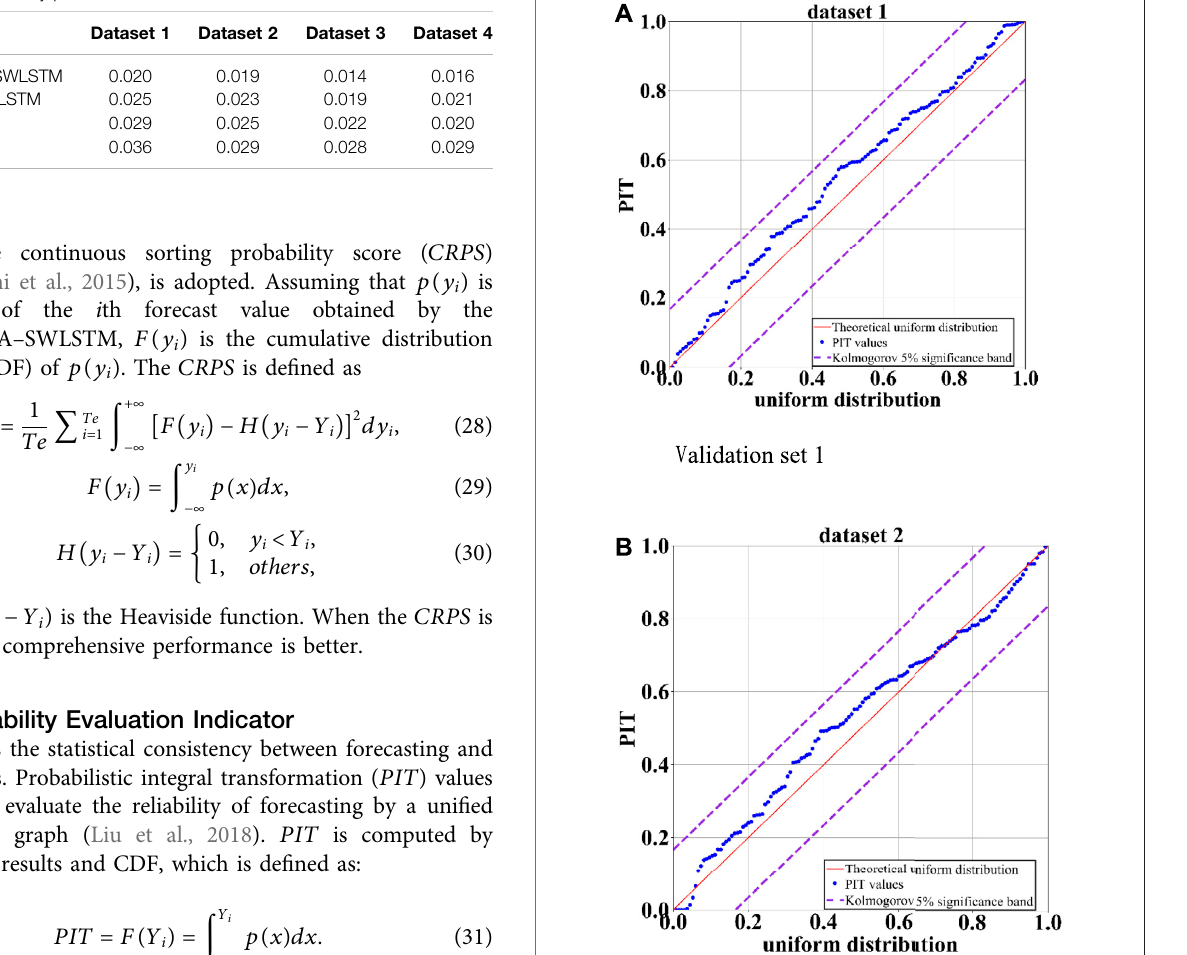
TABLE 4 | Probability prediction metrics in each dataset.